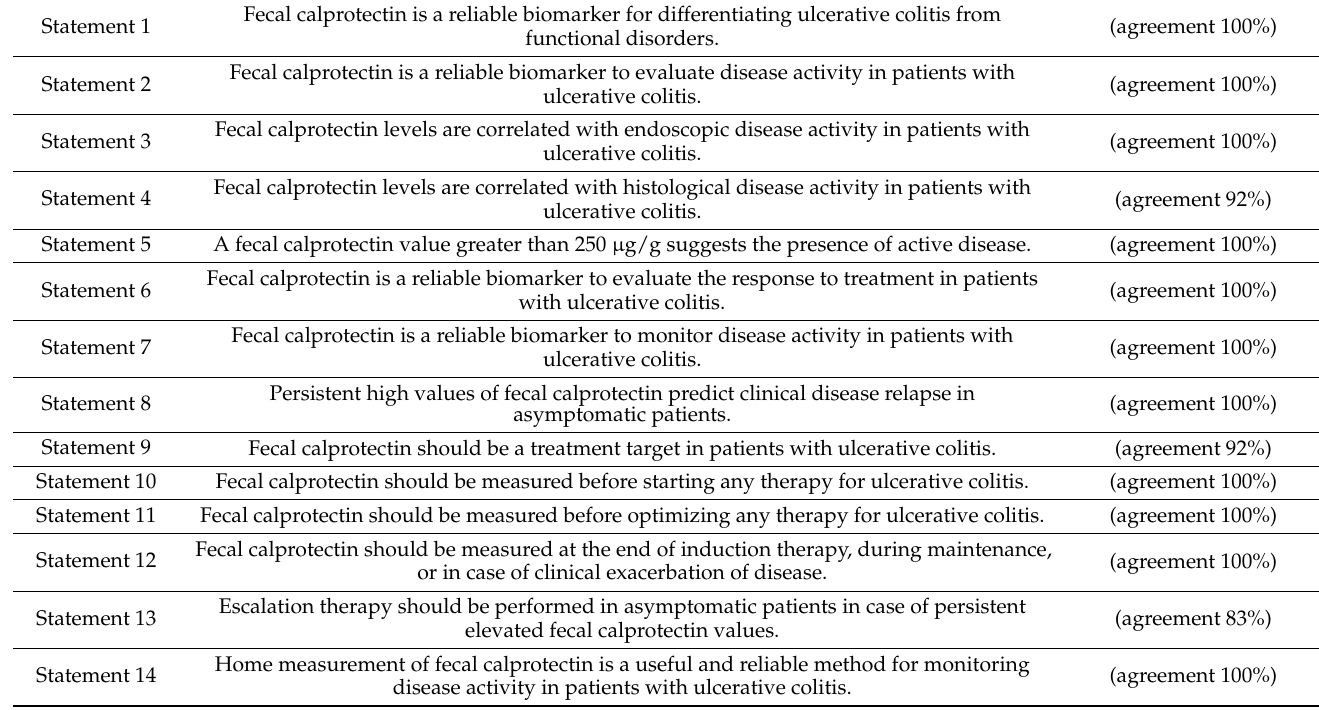
Table 2. Approved statements regarding the measurement of fecal calprotectin in the management of patients with inflammatory bowel